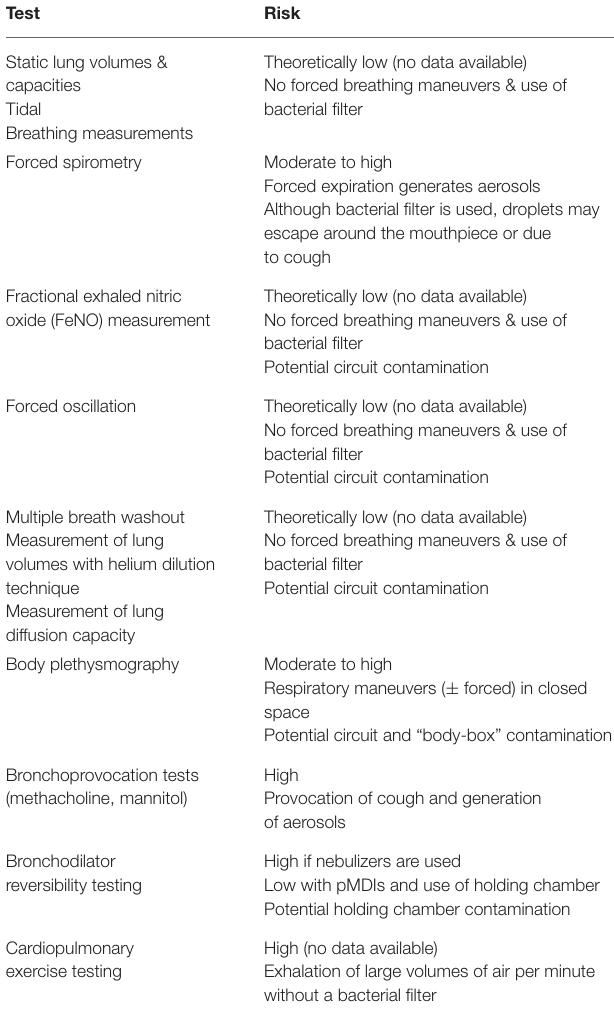
TABLE 1 | Pulmonary function tests and risk of cross